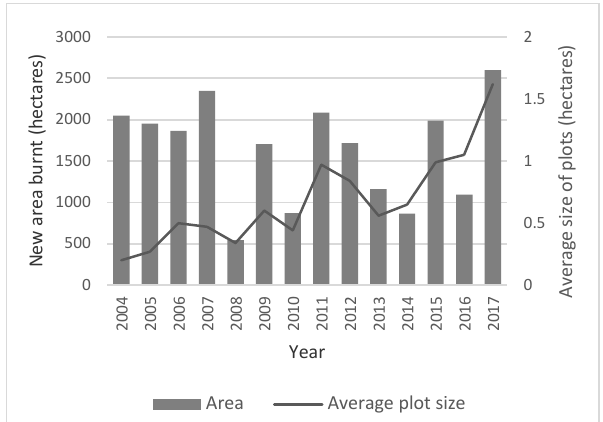
Figure 7. Total area cultivated each year along with the average size of plots burnt Year Area cultivated